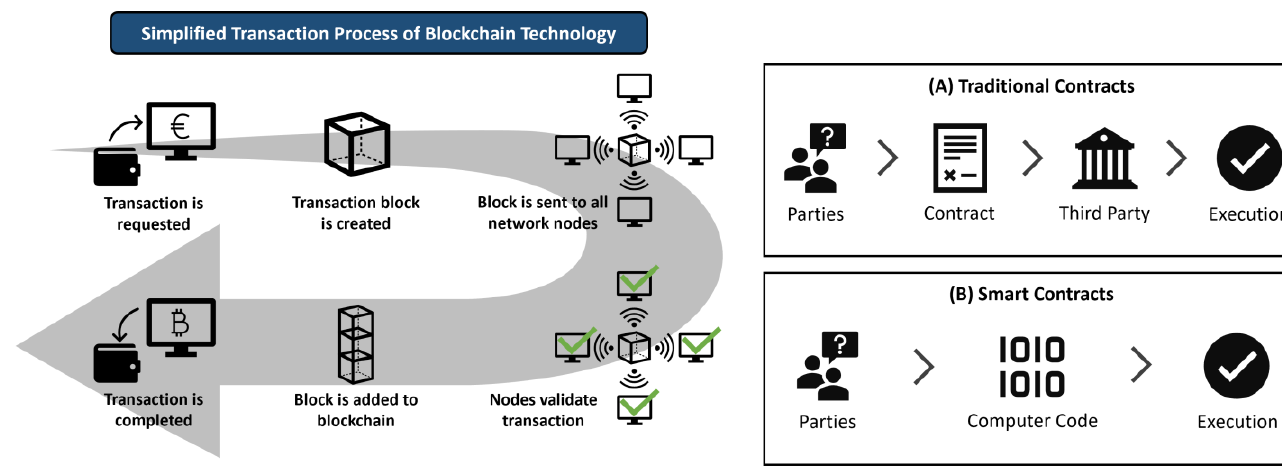
Figure 5. Diagrams of the transaction process of blockchain technology and comparison between: ( A ) traditional and ( B ) smart contracts.